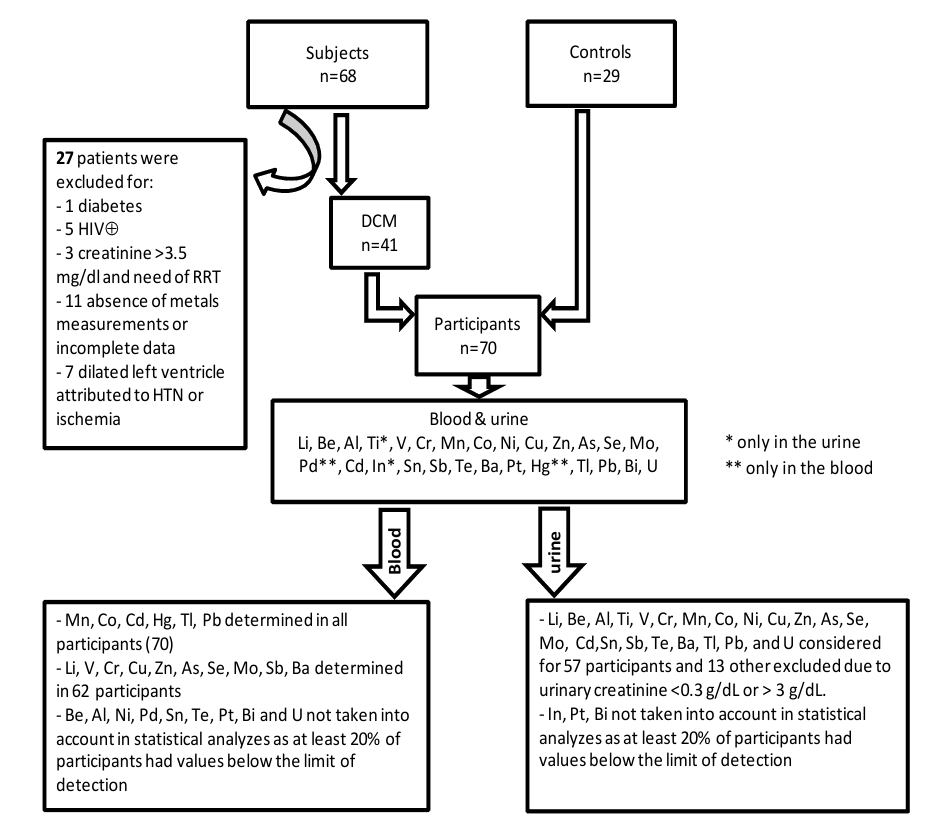
Figure 1. Patient selection, heavy metals measured in total blood and urine. LV denotes left ventricle, HIV ⊕ : human immunodeficiency virus positive test, RRT: renal replacement therapy, HTN: hypertension, DCM: dilated cardiomyopathy (idiopathic and postpartum cardiomyopathy).